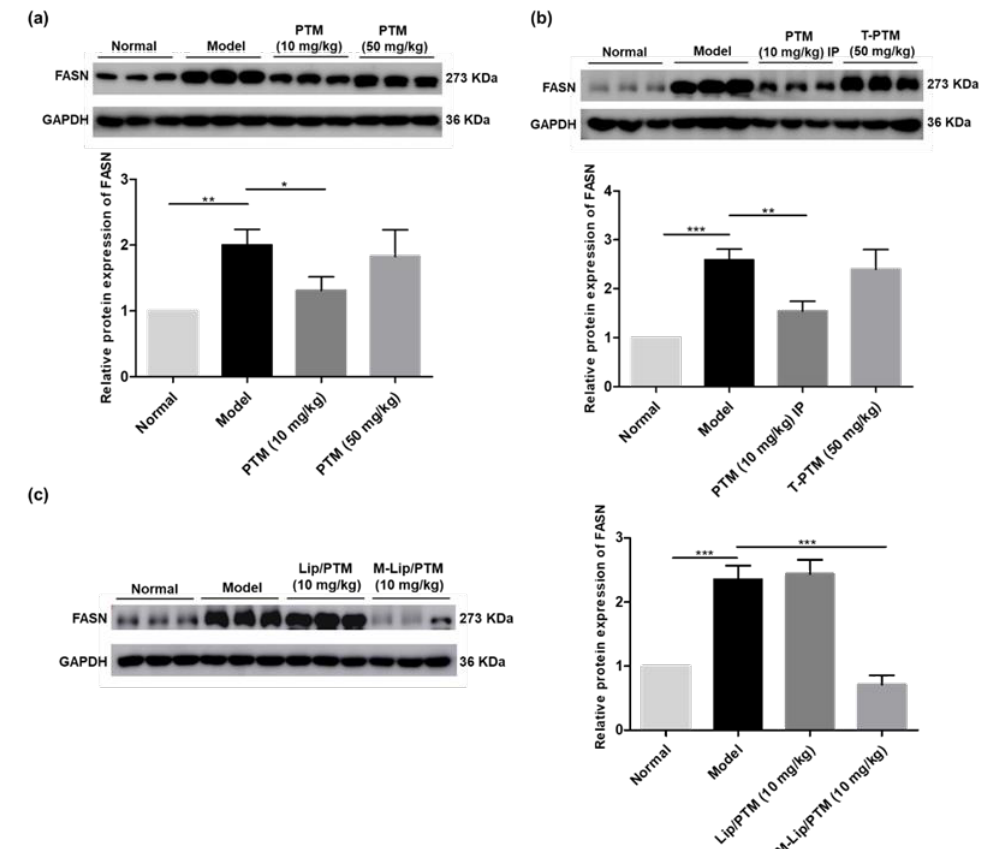
Figure 3. Effects of PTM and PTM-loaded liposome nanoparticles on FASN protein expression in mouse liver tissue. ( a ) Western blot analysis of FASN protein expression after 10 mg/kg and 50 mg/kg PTM oral treatment for 13 weeks. ( b ) Western blot analysis of FASN protein expression after 50 mg/kg PTM oral treatment and 10 mg/kg PTM intraperitoneal injection treatment for 5 weeks. ( c ) Western blot analysis of FASN protein expression after 10 mg/kg Lip/PTM and 10 mg/kg M-Lip/PTM intraperitoneal injection treatment for 5 weeks. Data are expressed as means ± SD, n = 3 mice per group. * p < 0.05, ** p < 0.01, *** p < 0.001.